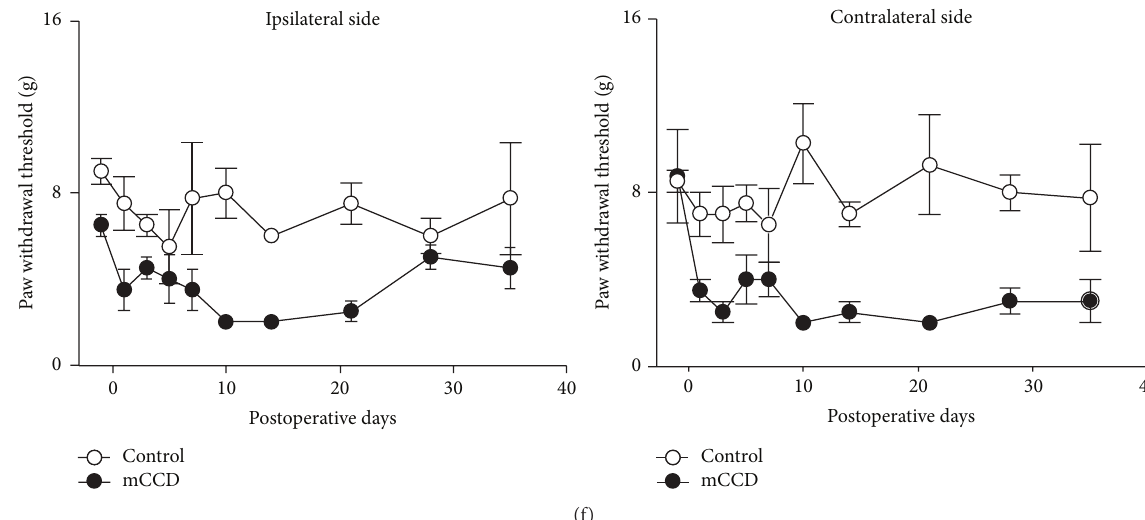
Figure 2: Behaviors of spontaneous pain, mechanical allodynia, and hyperalgesia recorded in mCCD rats. (a) The increase of the number of “wet-dog shaking” (WDS) behaviors at different time points after the mCCD (RM ANOVA, 𝑃 < 0.01 ). (b) The increase of the number of shrinking bilateral hind paws at different time points after the mCCD (RM ANOVA, 𝑃 < 0.01 ). (c) Hind paw withdrawal thresholds were markedly decreased bilaterally after the chronic compression ( 𝑛 = 29 ) compared to those of control ( 𝑛 = 35 ) and sham groups ( 𝑛 = 6 ) (on 10th postoperative day, one-way ANOVA followed by Bonferroni tests, ∗∗ 𝑃 s < 0.01 compared to those of control group, ## 𝑃 s < 0.01 compared to those of sham group). (d) Stimulus response curves of ipsilateral and contralateral hind paws to von Frey filaments. Following the chronic compression of multiple DRGs ( 𝑛 = 10 ), the stimulus response curves of both hind paws were markedly shifted to the left compared to those of the control group ( 𝑛 = 6 ) (general line model, all 𝑃 s < 0.05 ), and there was an obvious significant increase in the response frequency to 2.0 and 6.0 g von Frey filaments (nonnoxious mechanical stimuli) of both the ipsilateral and contralateral sides (Bonferroni test, 𝑃 s < 0.01 ). There was also a significant increase in the response to 8.0 and 10.0 g von Frey filaments (which were noxious mechanical stimuli) bilaterally (Bonferroni test, 𝑃 s < 0.01 ). (e) The time course of ipsilateral and contralateral hind paw mechanical withdrawal thresholds after chronic compression of multiple DRGs (mCCD group: 𝑛 = 29 ; control group: 𝑛 = 35 ; sham group: 𝑛 = 6 ). The ipsilateral hind paw withdrawal thresholds were decreased significantly below baseline on the 1st postoperative day and remained low throughout the entire testing period (RMANOVA, 𝑃 s < 0.01 ). Contralateralmechanical thresholdsweresimilarlydecreased toalesserextent onthe1stpostoperativeday, reached their lowest peak during the 10th to 14th postoperative day (RM ANOVA, 𝑃 s < 0.05 ), and recovered to basal levels thereafter. (f) Bilateral mechanical hypersensitization occurred in bilateral forepaws in the mCCD rat (mCCD group: 𝑛 = 4 ; control group: 𝑛 = 4 ; RM ANOVA, 𝑃 s < 0.05